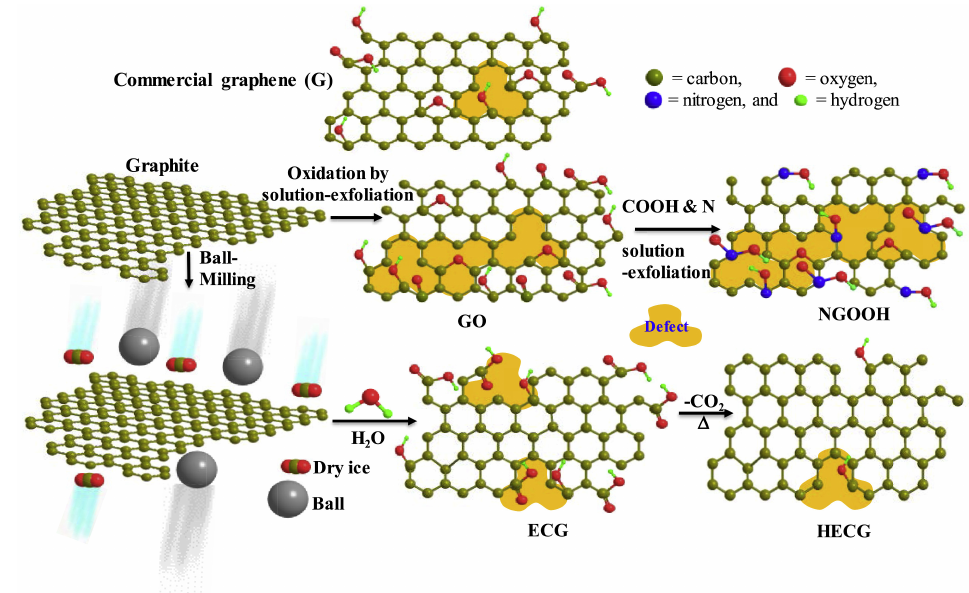
Figure 15. Schematics of the synthesis of nitrogen-doped carboxylic graphene (NGOOH), edge-carboxylated graphene nanoplatelets (ECG), and heat-treated edge-carboxylated graphene nanoplatelets (HECG). Reprinted with permission from Ref. [53]. 2019, Elsevier.